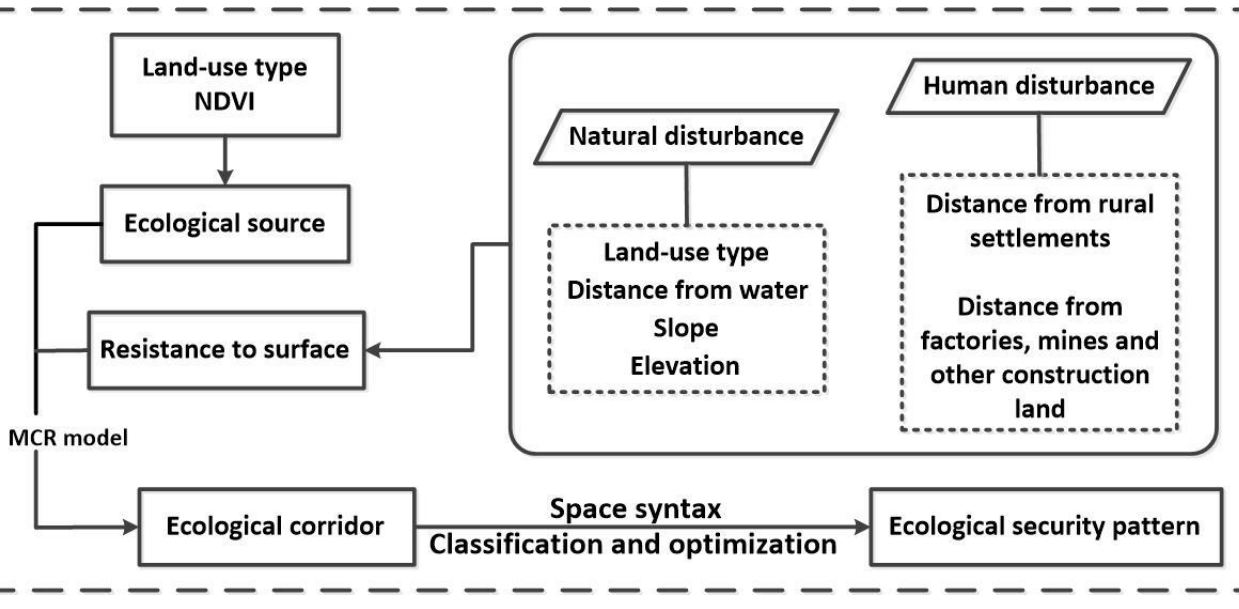
Fig. 2. Technical route. Figure 2. Technical